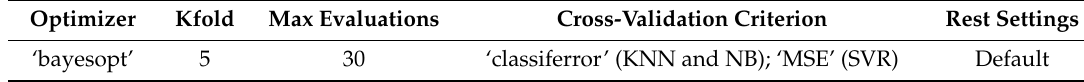
Table A8. Matlab machine learning optimization toolbox key parameter settings.